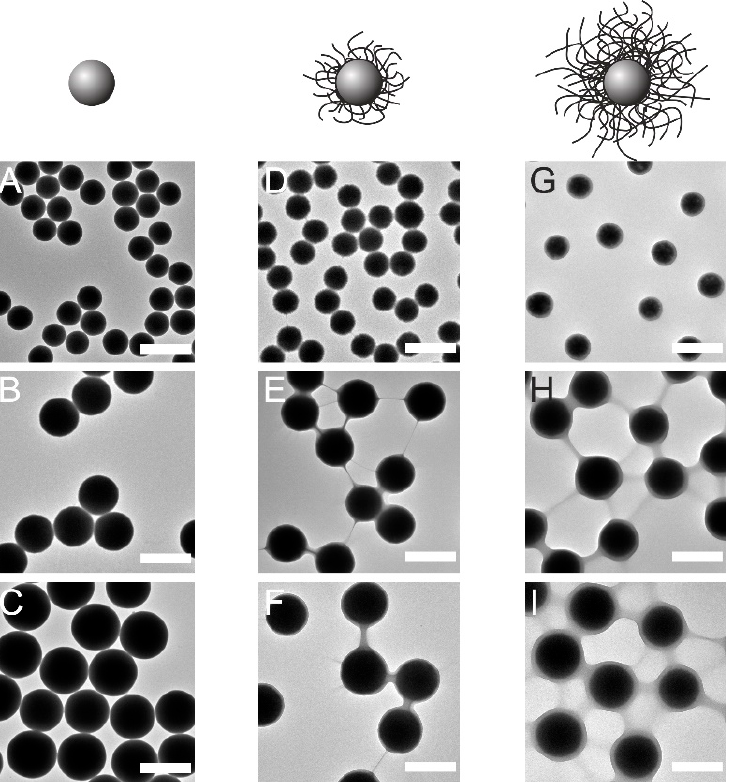
Figure 1. TEM images of CS microgels with variously sized cores: C 245 ( A ), C 388 ( B ), and C 455 ( C ), with thin shells: C 245 S 1.7 ( D ), C 388 S 2.1 ( E ), C 455 S 2.1 ( F ) and with thicker shells: C 245 S 2.9 ( G ), C 388 S 2.6 ( H ), C 455 S 2.3 ( I ). The scale bars correspond to 500 nm.